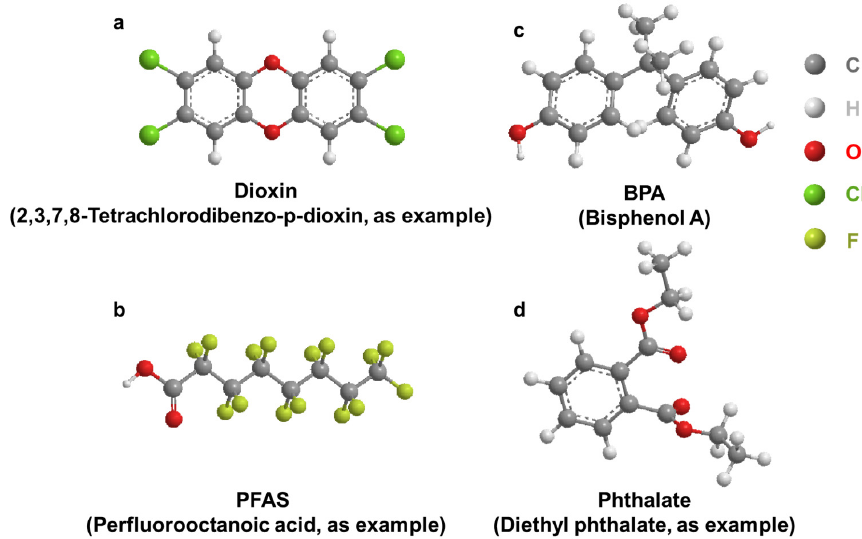
Figure 2. General structure of select EDCs. ( a ): Dioxin; ( b ): BPA; ( c ): PFAS; ( d ):